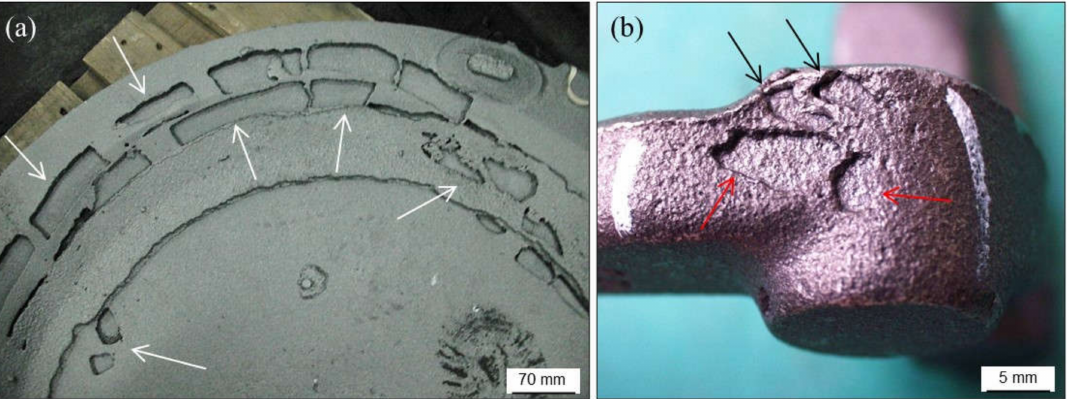
Figure 28. Solid scabs found in ( a ) a heavy-section ductile iron valve manufactured in a green sand mold with large flat surfaces; ( b ) a ductile iron